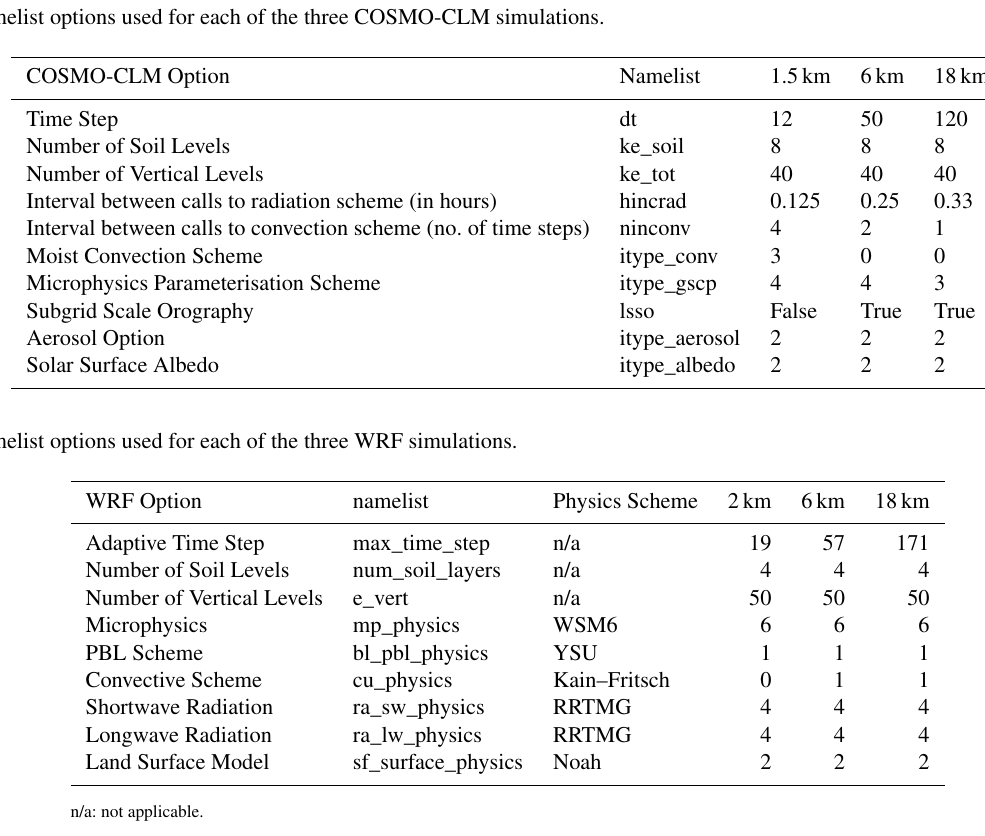
Table 1. Namelist options used for each of the three COSMO-CLM simulations. COSMO-CLM Option